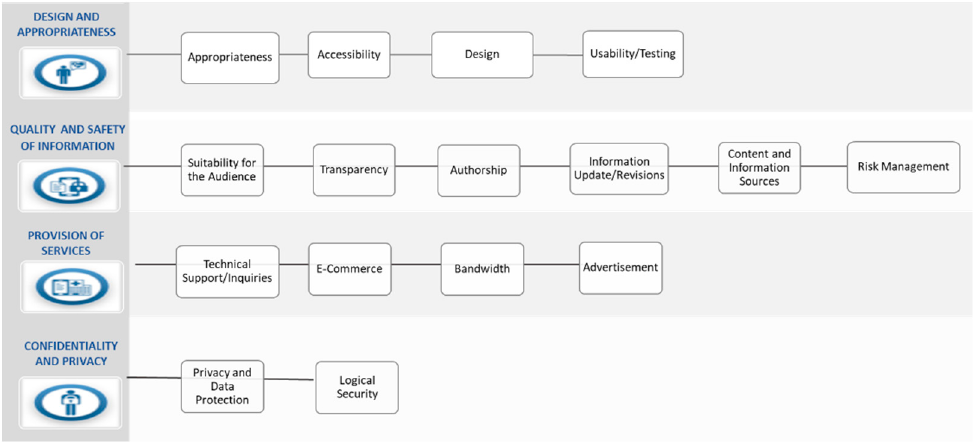
Figure 1. Recommendations on design, use and assessment of health apps. Source: Andalusian Agency for Healthcare Quality.